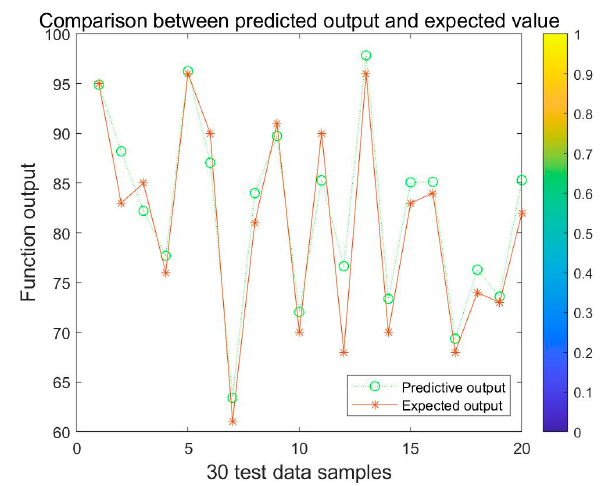
Figure 5. Comparison of training and expected output results.